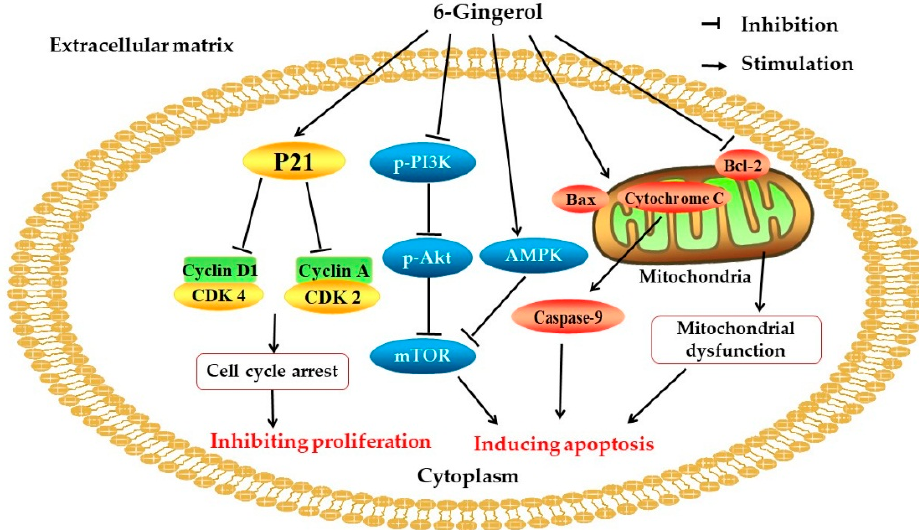
Figure 2. Several signaling pathways are involved in the anticancer mechanisms of 6-gingerol. CDK: Cyclin-dependent kinase; PI3K: Phosphoinositide 3-kinase; Akt: Protein kinase B; mTOR: Mammalian target of rapamycin; AMPK: 5’adenosine monophosphate-activated protein kinase; Bax: Bcl-2-associated X protein; Bcl-2: B-cell lymphoma 2.